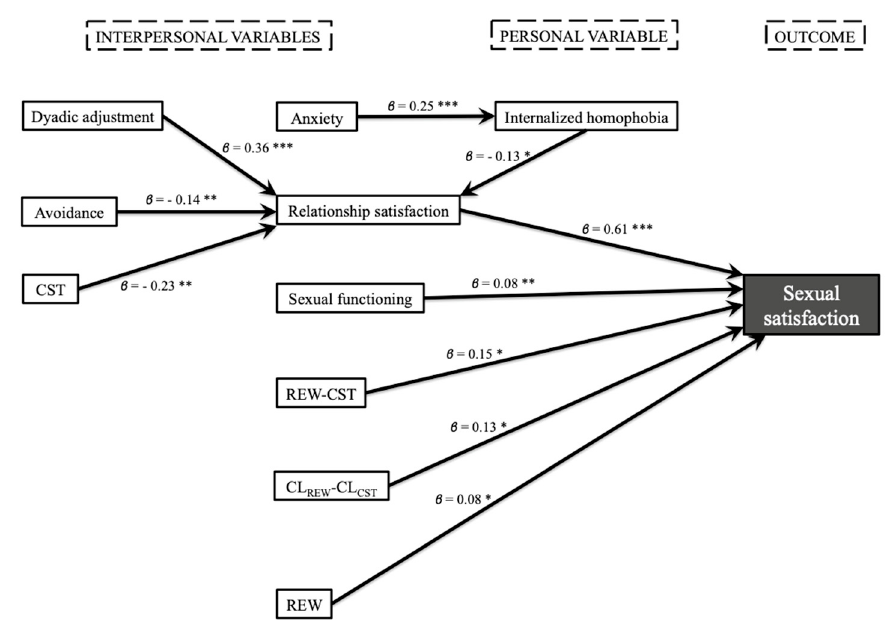
Figure 1. Explanatory model of sexual satisfaction in men with a same-sex partner ( n = 410, * p < 0.05, ** p < 0.01, *** p < 0.001).